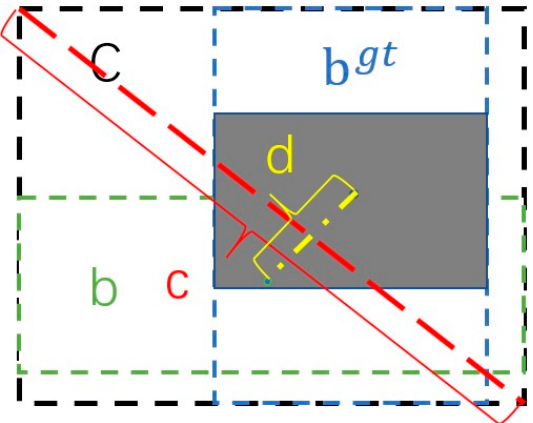
Figure 11. Example of detection frame.